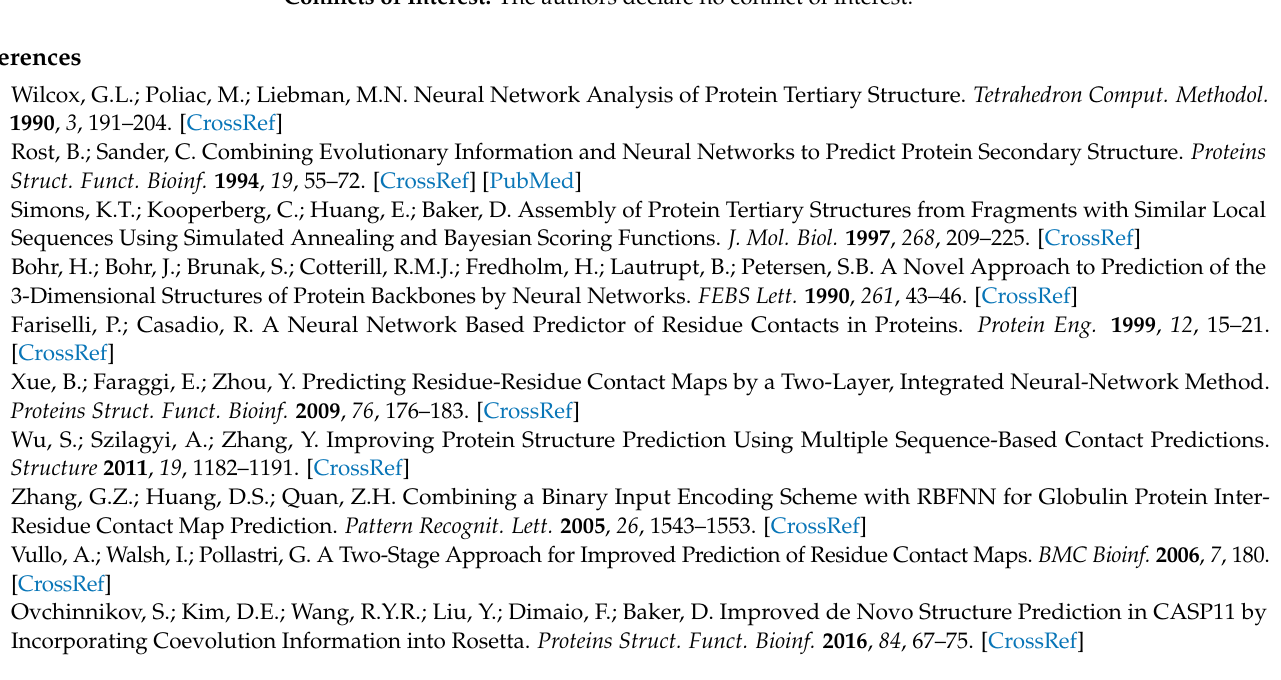
method. After quantification by Western blot, the exact number of protein lysates were filtered to ass in pre-cultured COS 7cells. (B) mRFP-Sp protein was detected majority around cell surface either via RFP (data not shown) or Spike protein antibodies’ staining. (C) Binding affinity by dosage. Different concentrations of spike protein lysates were added to measure the binding curve. Around 100 ng spike protein is reaching the station platform. Scale bar: 20 µ m. Figure S3: Cell in fusion assay. (A) ACE2- eGFP was transfected in COS7 cells and correctly confirmed expression pattern by ACE2 antibody. (B) 293T cells were separately transfected with eGFP, ACE2-eGFP, mRFP, and mRFP-Sp. Overnight transfected cells were trypsinized, and ACE2-eGFP was mixed with mRFP-Sp for cells in fusion assay. Other combinations were taken as control. (C) Cell in fusion was only observed in the combination of ACE2-eGFP and mRFP-Sp. No infusion phenome was observed in control combinations. Scale bar: 20 µ m. Table S1: The list of mutations that each variant possessed compared to the original spike protein sequence from the COVID-19 virus pathogen identified in Wuhan, China, provided by the CDC (https://www.cdc.gov/coronavirus/2019-ncov/variants/variant-classifications.html, accessed on 23 June 2021). Table S2: The table represents the HADDOCK parameters of naturally occurring variants after refinement. Table S3: The table represents the binding affinity and number of interactions between the trRosetta-generated RBDs and the ACE receptor of 6M0J generated by the PRODIGY server. Table S4: RMSD (root mean square deviation of atomic positions) score for trRosetta-generated mutated RBD models. The root-mean-square deviation of atomic positions is the measure of the average distance (Å) between the atoms of superimposed proteins. Table S5: The table represents the HADDOCK parameters of all the manually mutated variants after refinement. Table S6: The table represents the binding affinity and number of interactions between the trRosetta-generated RBDs and the ACE receptor of 6M0J generated by the PRODIGY server. Author Contributions: Conceptualization, T.J. and Y.Y.; methodology, T.J., W.W., F.Z. and